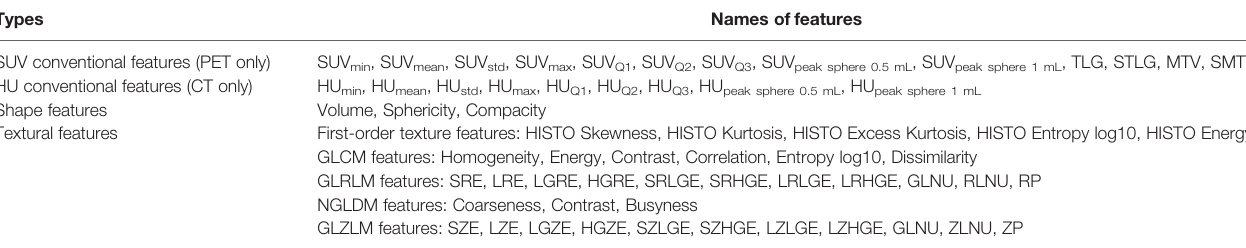
TABLE 1 | Image features extracted in our study.